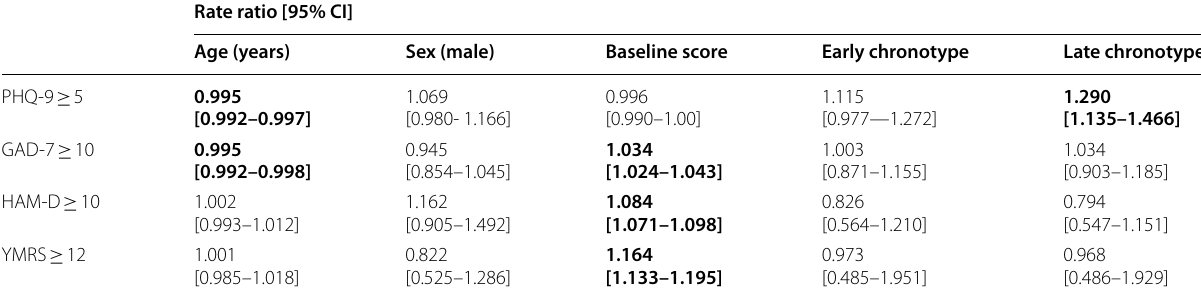
Females and normal chronotype were used as reference groups Bold RRs are significant at p <